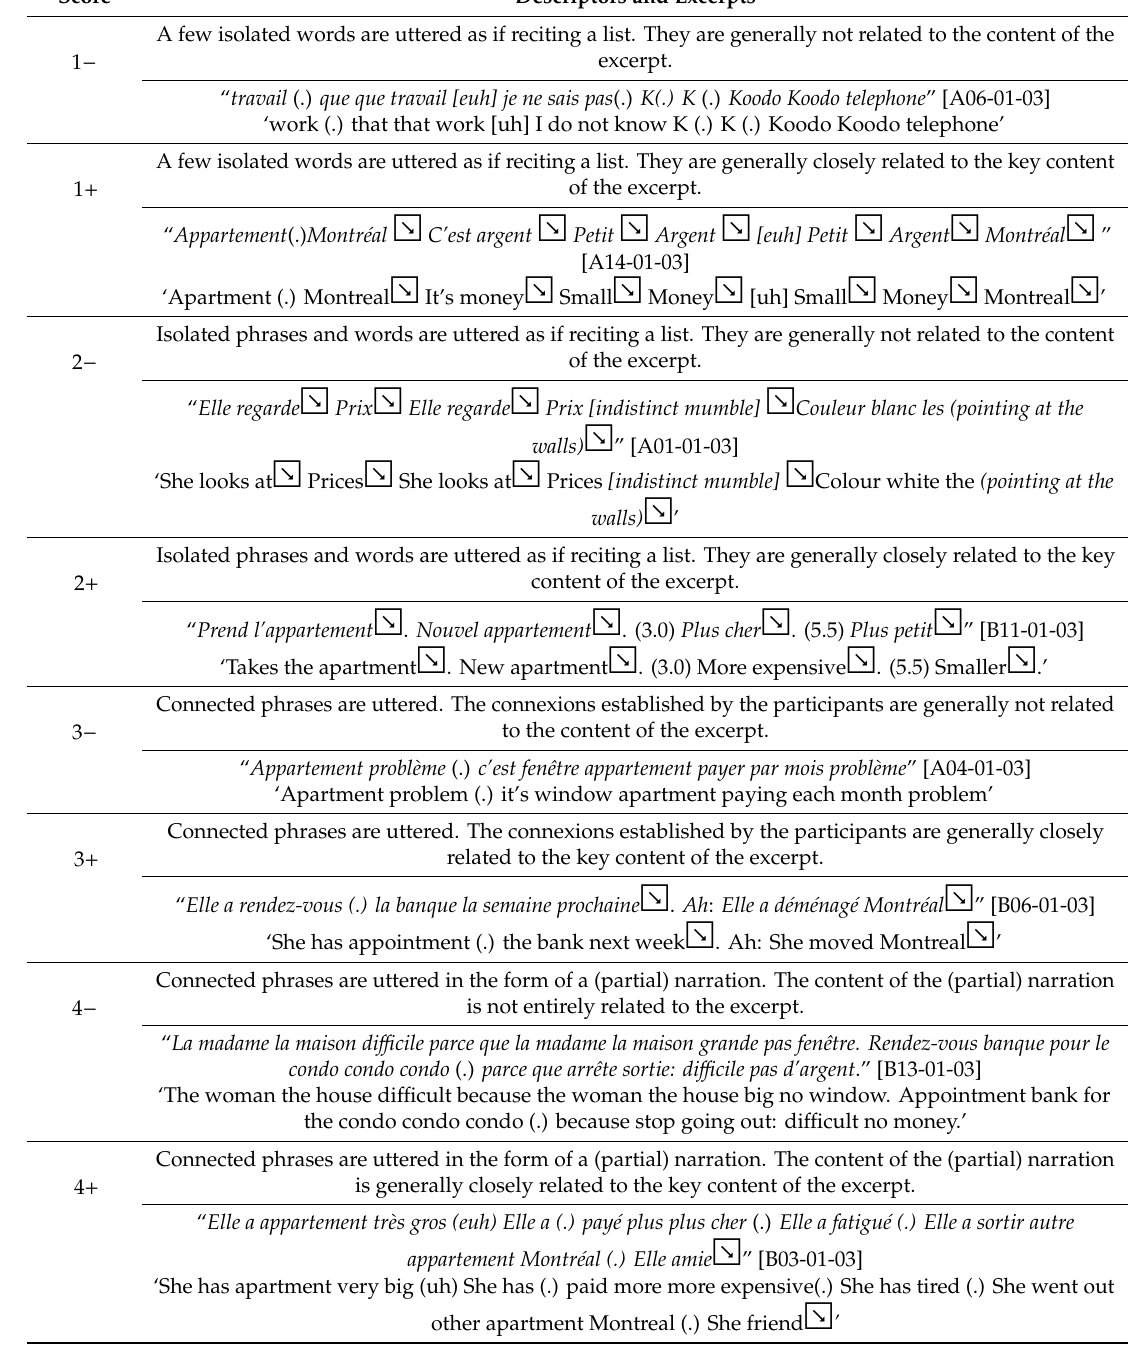
Connected phrases are uttered in the form of a (partial) narration. The content of the (partial) narration is generally closely related to the key content of the excerpt.